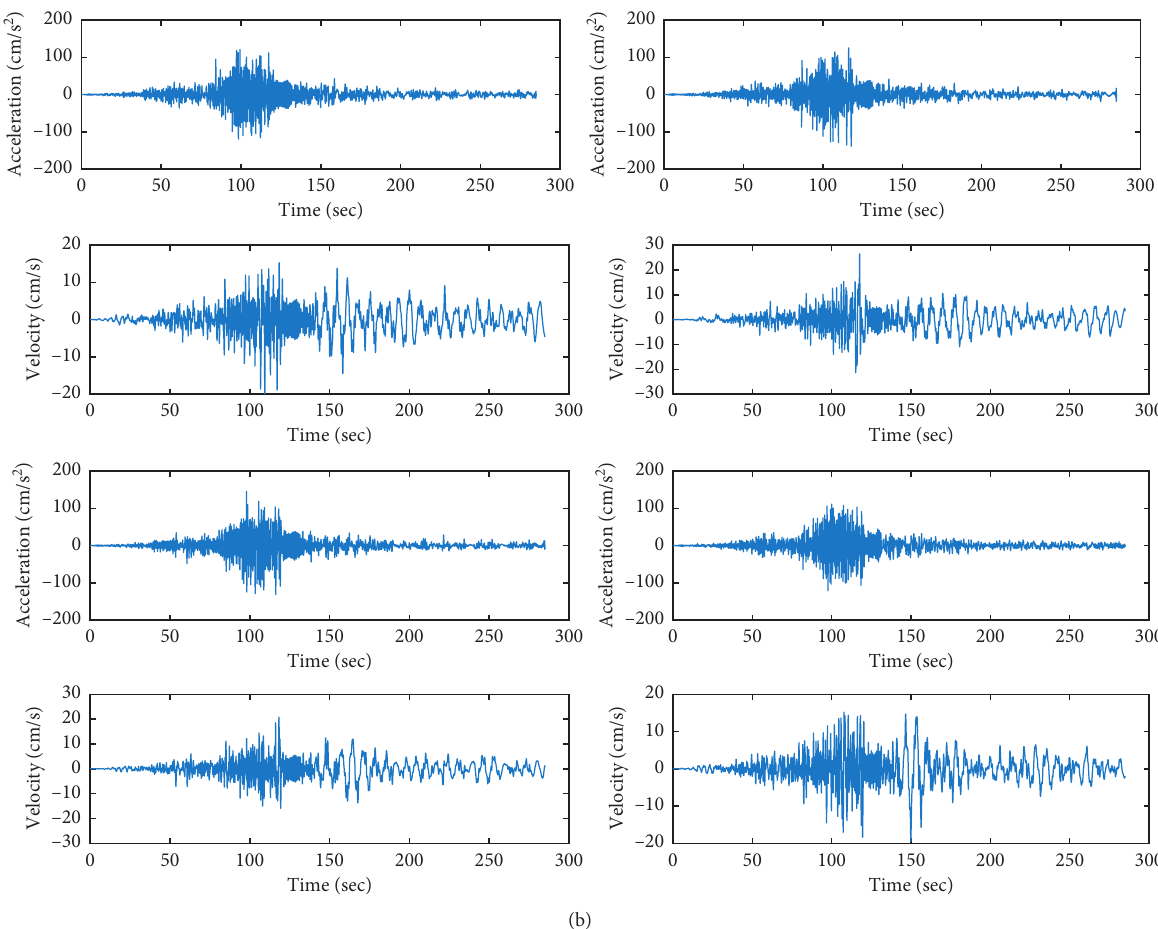
Figure 20: Samples of the simulations in the form of acceleration and velocity time series. (a) CHB002EW and (b)